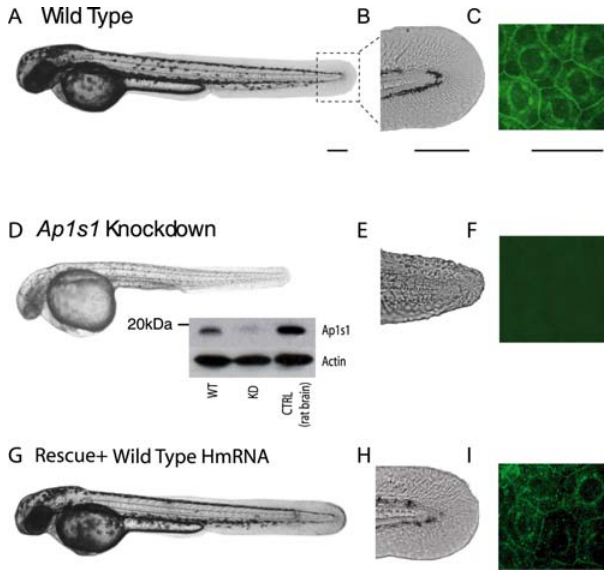
Figure 2. Morphological phenotype of Ap1s1 knockdown zebrafish is rescued by over expression of human AP1S1 . Transmitted light images of 48 hpf Ap1s1 KD larvae show their smaller size, reduced pigmentation (D) and skin disorganization (E) compared to the WT (A, B) and the rescued larvae (G,H). Immunofluorescence of wholemount zebrafish using anti-Ap1s1 antibody showing localization of Ap1s1 to the plasma membrane (C, polygonal) and to a well defined perinuclear ring, in both normal (C) and rescued larvae (G), whereas only a residual and diffuse staining could be observed in KD larvae (F). Western blot analysis (D, inset) indicates nearly complete knockdown of Ap1s1 protein (WT=wild-type, KD=knockdown, CTRL=control rat brain proteins). To normalize the western blot analysis, proteins extracted from WT, KD and CTRL larvae were incubated with anti-actin. Scale bars in (A, D, G)=100 m m, (B, C, E, F, H, I-Ciii)=50 m m.